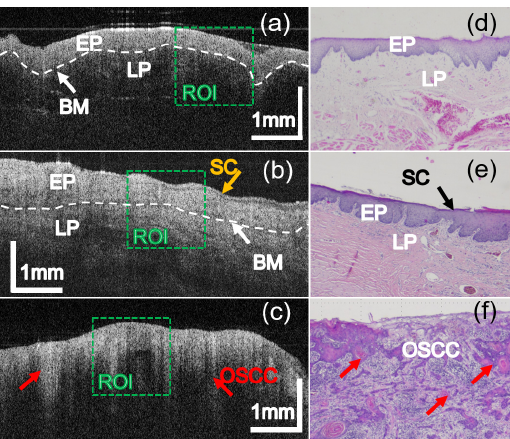
Figure 1. Morphological characteristics and statistical analysis of oral tissues. The representative OCT images of normal mucosa ( a ), LEH ( b ), and OSCC ( c ) and corresponding histopathological images ( d – f ). The ROI indicates 256 × 256 pixels.